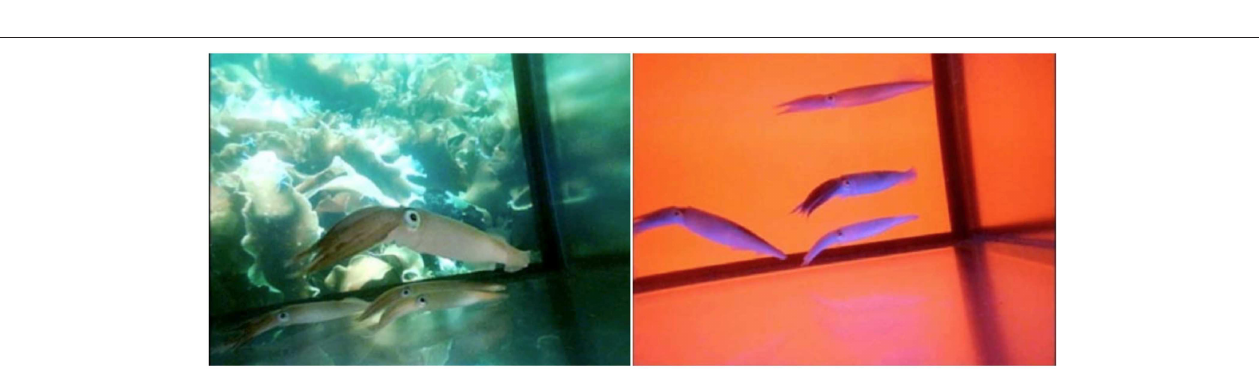
FIGURE 1 | The frequency of ocean science-related publications involving virtual reality has increased since the early 1990s. The search criteria for these works was focused on ocean data visualization-related terms, including both observed and modeled data. Google Scholar key word searches included: VR, virtual reality, immersive, 3D virtual environment, 3D user interfaces, telepresence, marine, underwater, oceanography, oceans, virtual, technology, head-mounted display, HMD, Oculus Rift, HTC Vive, CAVE. This search was concluded after a total of 150 citations was reached.